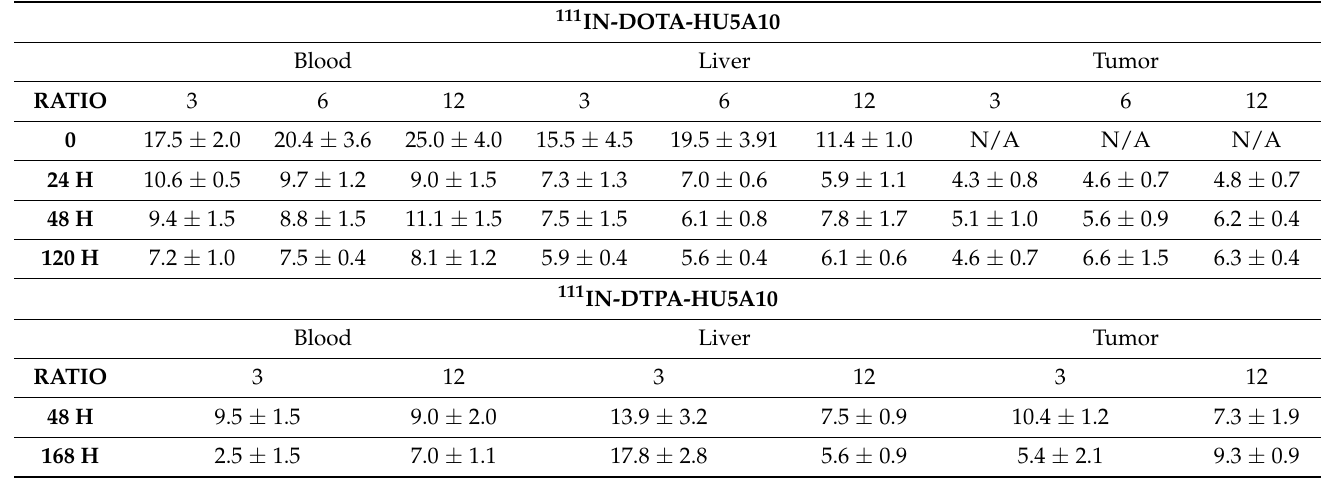
Table A1. The biodistribution for 111 In-CHX-A”-DTPA-hu5A10 and 111 In-DOTA-hu5A10 with 3:1, 6:1, and 12:1 chelator-to- antibody molar ratios in LNCaP xenografted BALBC-nu